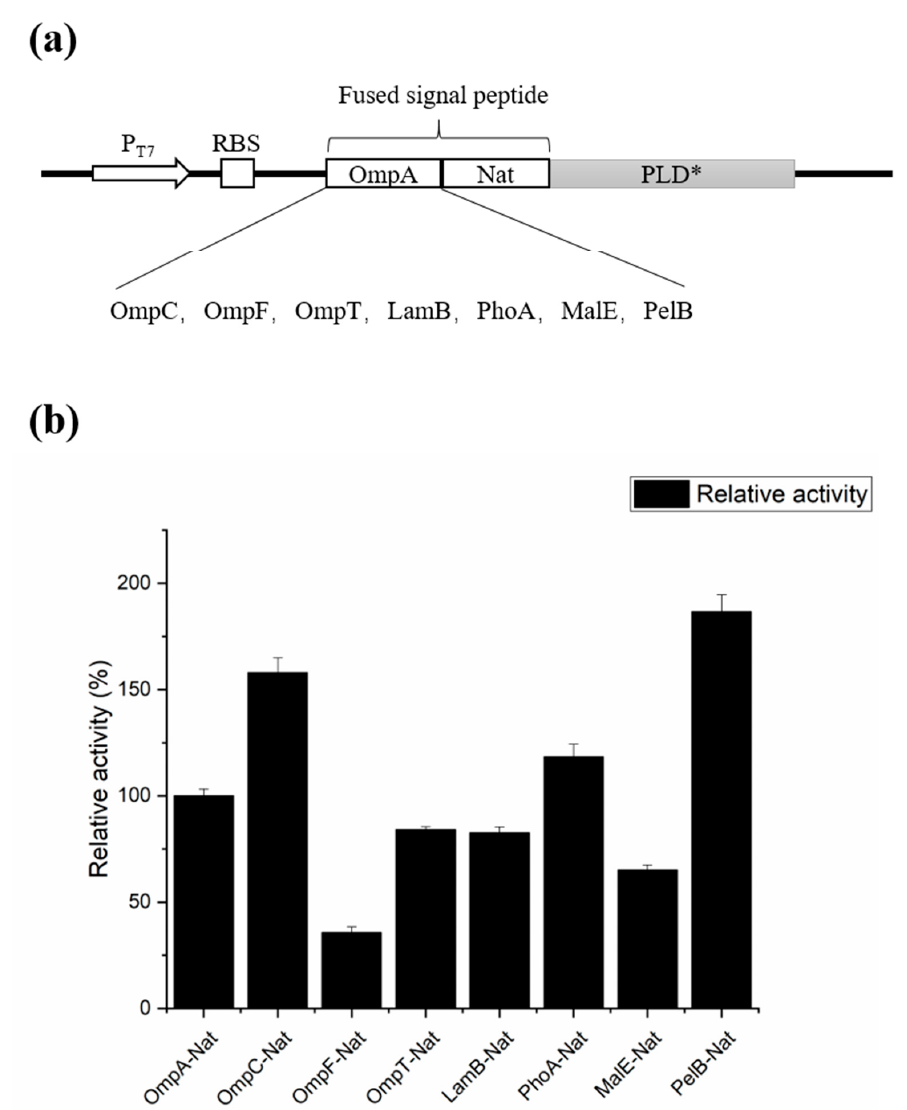
Figure 3. Optimization of the signal peptides for the secretory expression of PLD * in E. coli . ( a ) Using different signal peptides from E. coli to replace OmpA to construct different fused signal peptides. ( b ) The relative transphosphatidylation activity of recombinant PLD * when fused expressed in E. coli with different fusion signal peptides. The activity of PLD expressed by the strain BL21(DE3)/pET22b-OmpA-Nat-PLD * was the reference (100% relative activity).